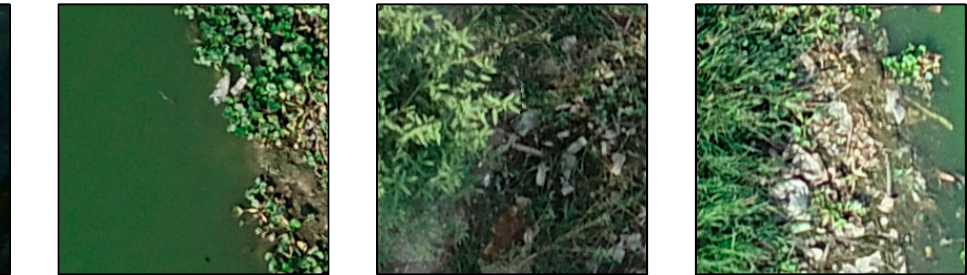
Figure 9. Both the TT model and the HMH model transferred to TT fail in some cases. Neither model detected any plastic in these images from TT.